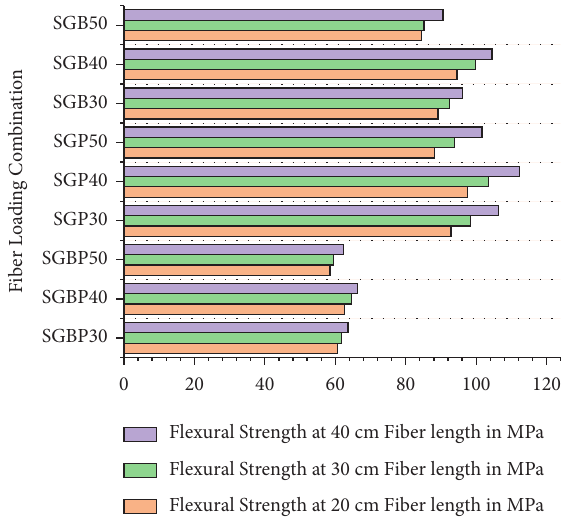
Figure 4: Graphical representation of flexural modulus for various samples at different fiber volumes and fiber